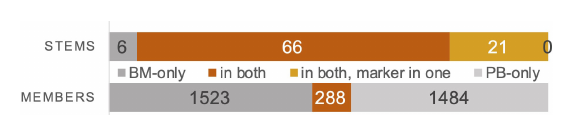
FIGURE 7 Overlap of marker DNJ-stems and their family members detectable in BM and PB. Total numbers of marker DNJ-stems (top) and DNJ- stem family members (bottom) that were found in only one of the compartments are illustrated in grey. Those that were overlapping between the compartments are illustrated in orange. In case of marker DNJ-stems, we distinguished between concordant marker status (dark orange) and detectable in both, but only marker status in one (light